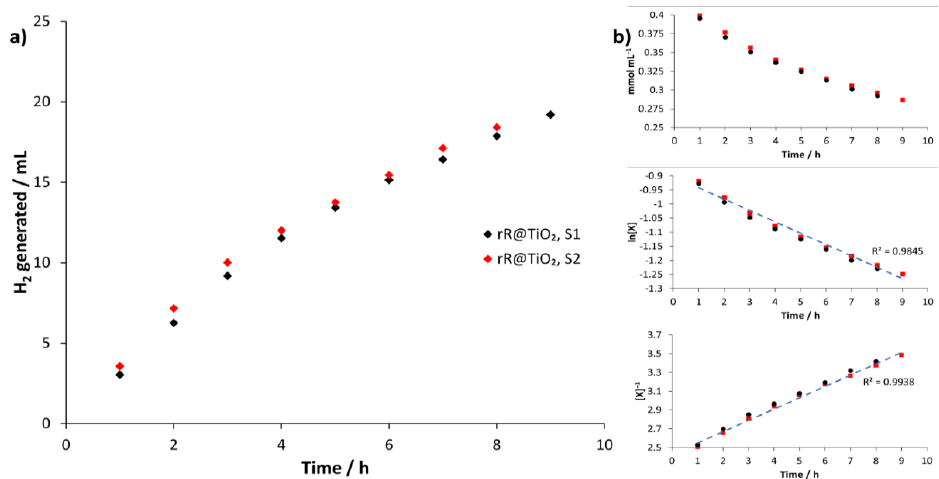
Figure 2. ( a ) Graphical representation of H 2 generated using rR@TiO 2 in mL during light irradiation experiments versus time for two samples. ( b ) Zeroth order reaction graph ( top ), concentration (mmol per mL) starting material during kinetic irradiation measurements of two samples (red and black) against time (hours); 1st order reaction graph ( middle ), natural logarithm of starting material concentration [X] during kinetic irradiation measurements of two samples (red and black) against time (hours), linear trendline through datapoints (blue); 2nd order reaction graph ( bottom ), One over concentration [X] of starting material during kinetic irradiation measurements of two samples (red and black) against time (hours), linear trendline through data points (blue).